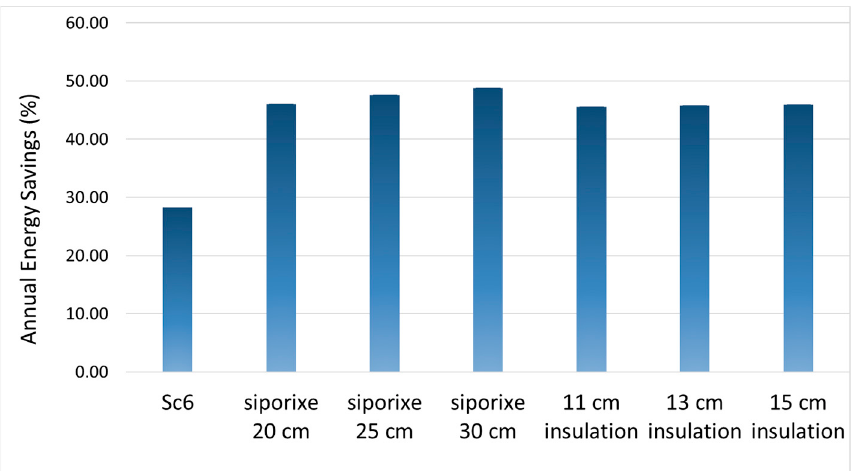
Figure 9. The comparison between Sc6 and wall and roof insulation in terms of annual energy con- sumption saving. consumption